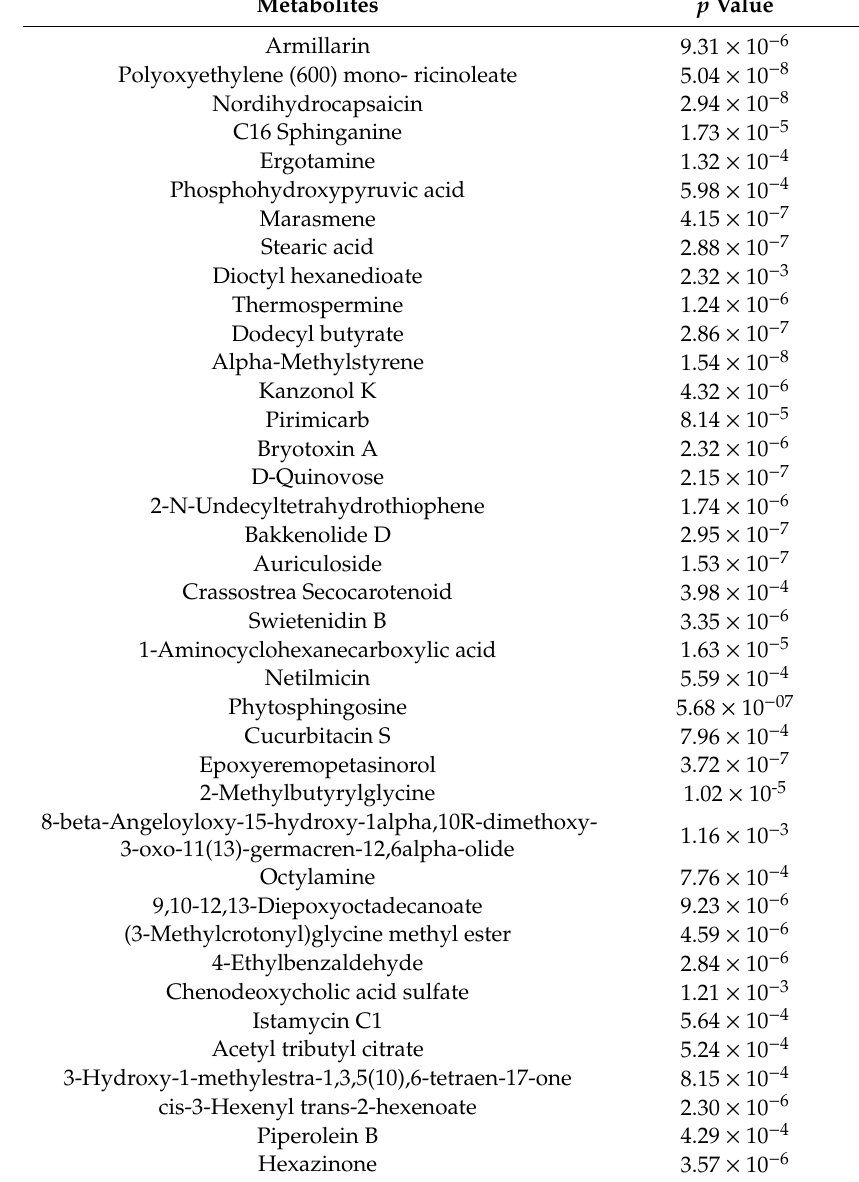
Table 2. List of Downregulated Metabolites in Ranibizumab-Treated HTFs Compared to Control HTFs. At p -value < 0.01 with a cut o ff value of two-fold change, 123 metabolites were significantly downregulated in the ranibizumab-treated HTFs group compared to the HTFs control